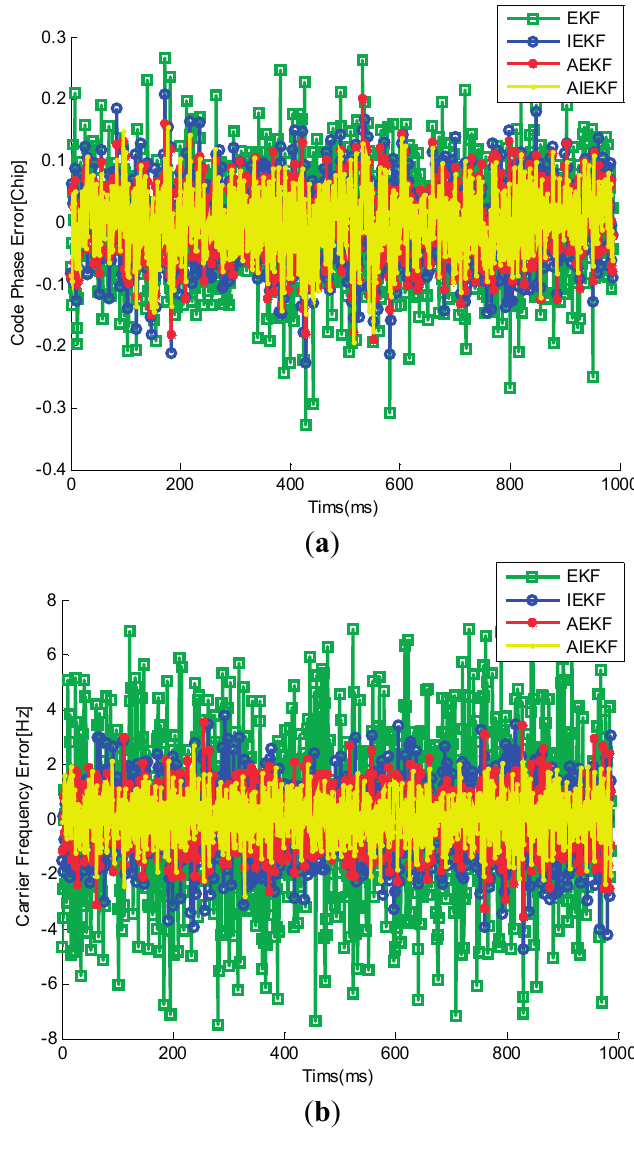
Figure 13. Code phase error and carrier frequency error of PRN 2 satellite. ( a ) Code phase error; ( b ) Carrier frequency error.